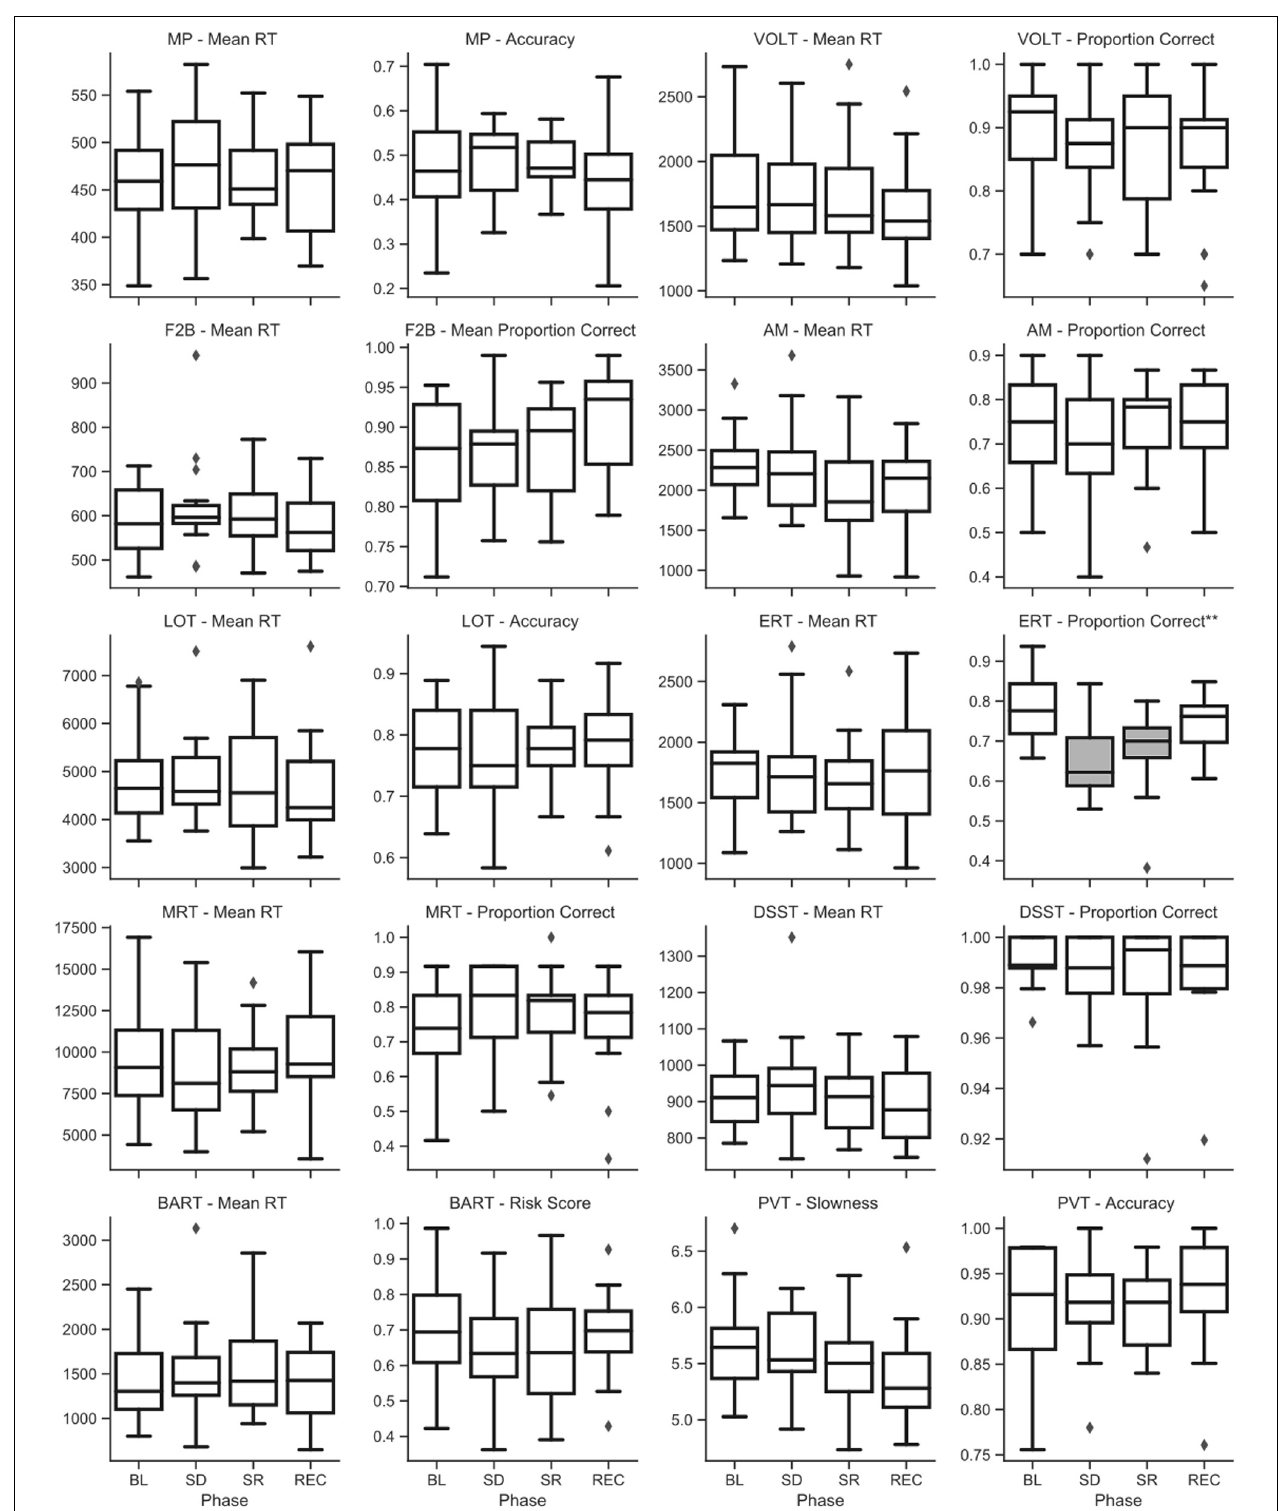
FIGURE 4 | Raw (untransformed) scores across sleep deprivation phases in campaign 1 of HERA on key speed and accuracy metrics of the Cognition battery. Asterisks in the sub-plot title refer to type-III significance levels of sleep deprivation as a main effect after adjusting for multiple testing with the false discovery rate method (* p < 0.05; ** p < 0.01; *** p < 0.001; **** p < 0.0001). In plots with a significant omnibus effect, data shaded in gray were significantly different from baseline (BL) in a post hoc t -test.